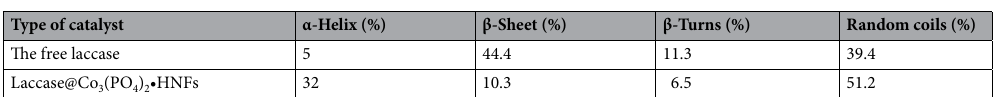
Table 1. Secondary structures content of the free laccase and laccase@Co 3 (PO 4 ) 2 •HNFs. * p < 0.05 vs. the free laccase.